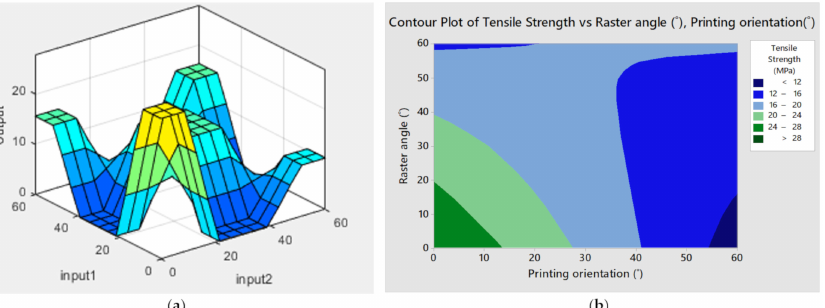
Figure 6. 3D plot ( a ) and controur plot ( b ) of tensile strength vs. raster angle and printing orientation.